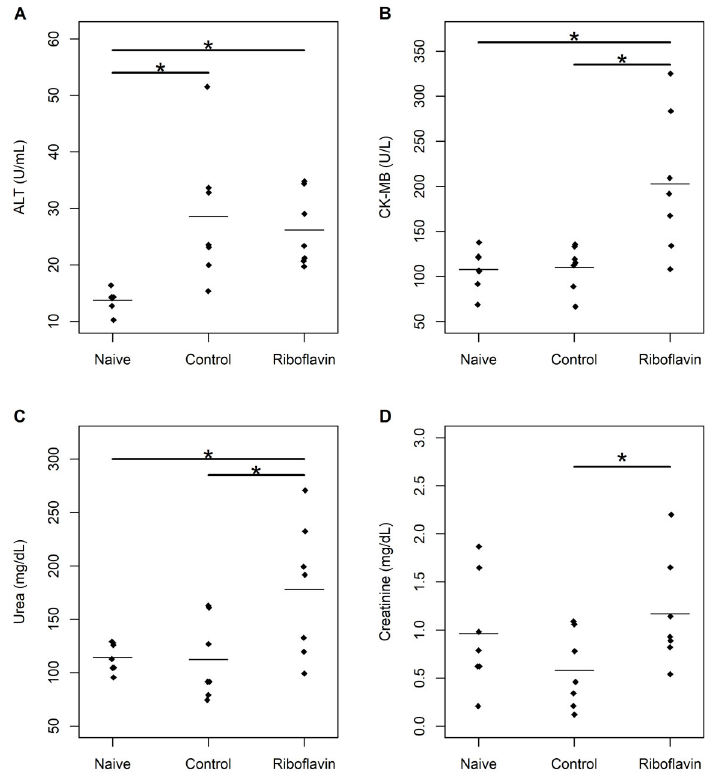
Figure 3. Serum concentrations of biomarkers of organ dysfunction in naïve, control, and study groups (n=7 animals per group). A , Alanine aminotransferase (ALT); B , creatine kinase-MB isoenzyme (CK-MB); C , urea; D , creatinine. The horizontal bars represent means. *Signi fi cant difference between groups (linear regression models adjusted under the Bayesian